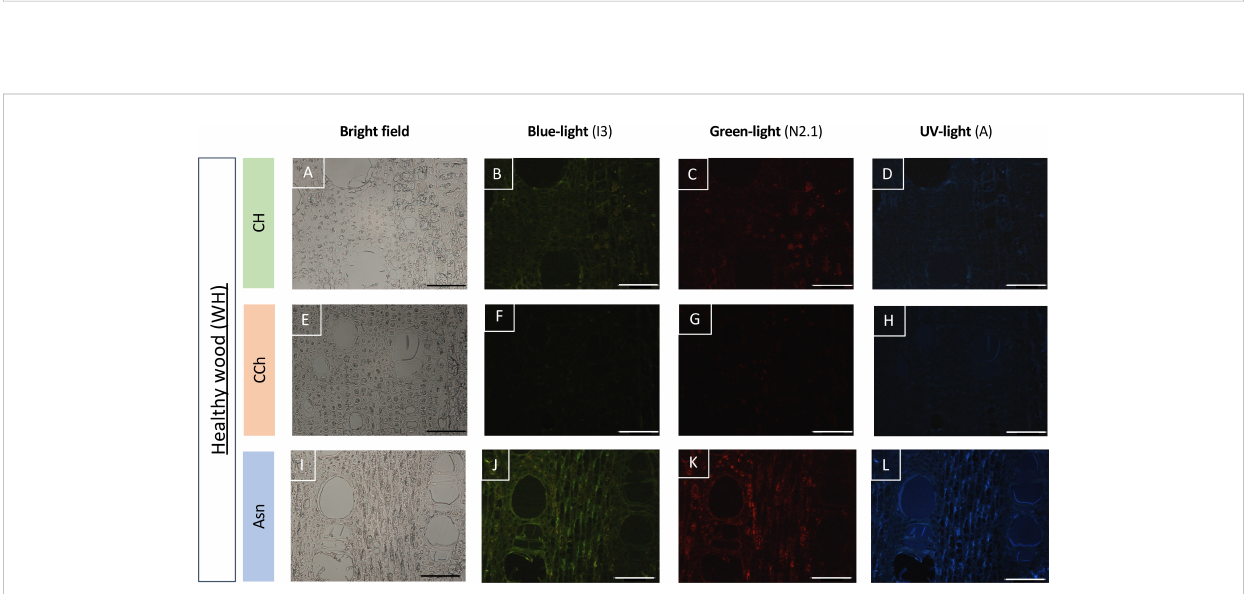
FIGURE 6 Observation of the auto fl uorescence of healthy woody tissues (WH) collected on CH (A – D) , CCh (E – H) , or Asn-treated vines (I – L) and compared according to different types of excitations (blue, green, or UV light) in epi fl uorescence microscopy (B – D, F – H, J – L) . For each modality, the observation of the same sample in bright fi eld microscopy is given respectively in A, E and I . A slight increase in the auto fl uorescence signal is observed, whatever the excitation wavelength experienced, in the Asn modality (J – L) . Bar: 100 m